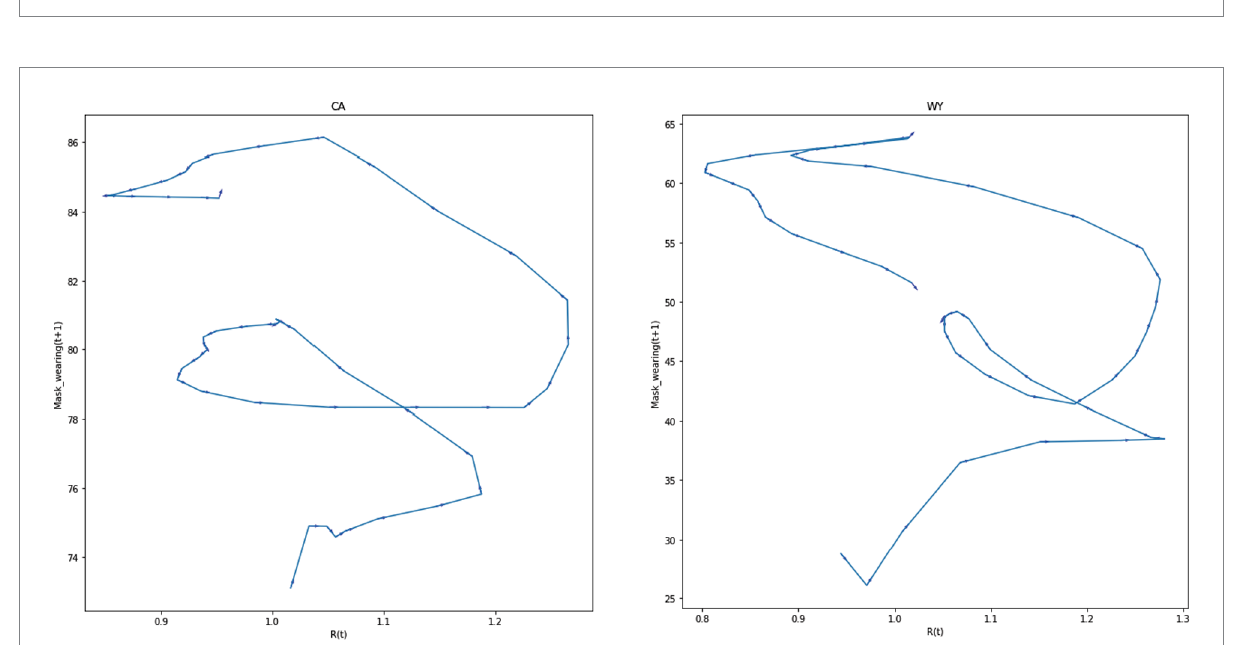
FIGURE 9 The oscillation of mask wearing and effective reproduction number in two United States